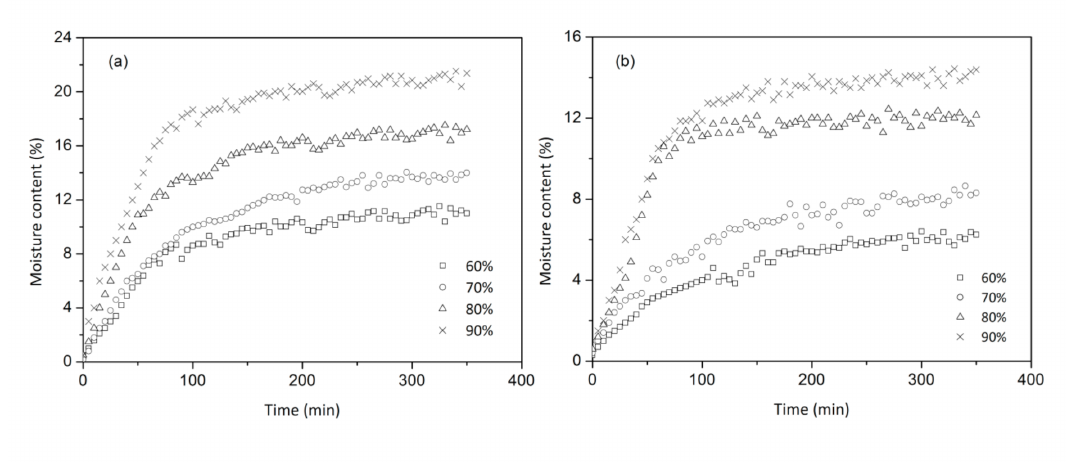
Figure 3. Moisture adsorption of: ( a ) pellets made from untreated straw; ( b ) pellets made from